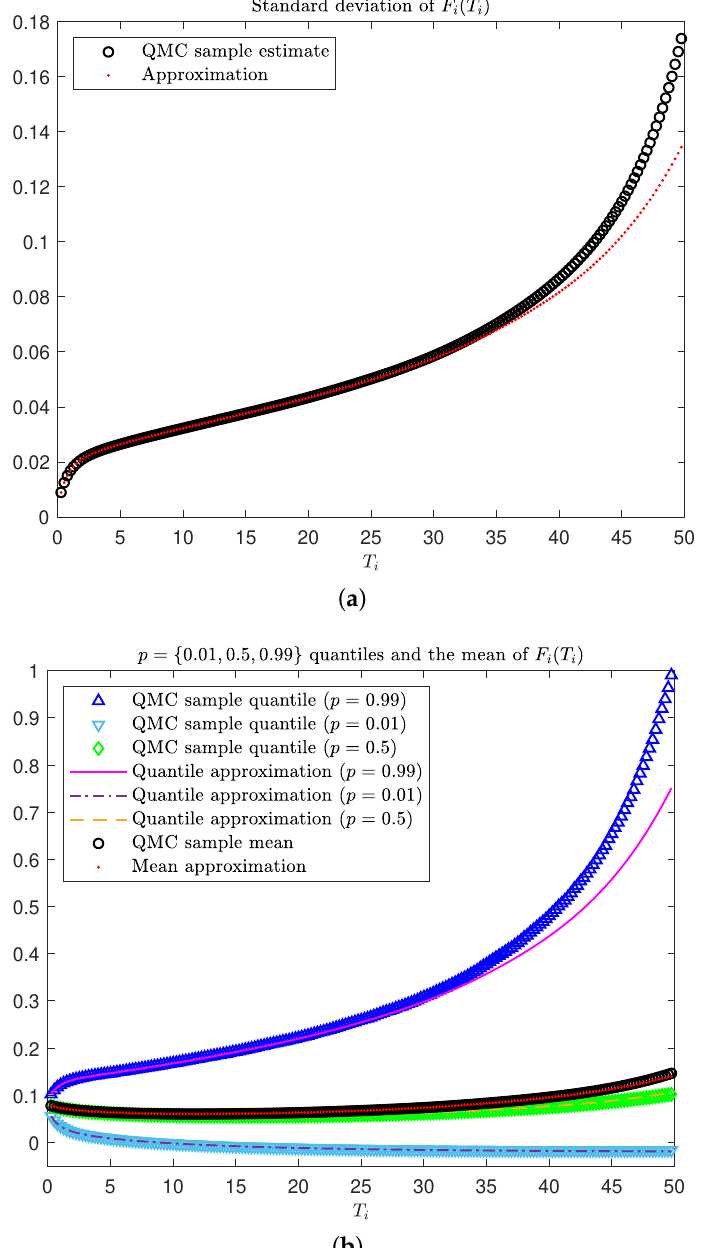
Figure 3. Diagnostic tool for analysing the distribution of long-dated forward LIBORs in the five-factor DLFM scenario. ( a ) Comparing the realised forward LIBOR standard deviation ap- proximation to a benchmark QMC sample estimate. ( b ) Comparing the realised forward LIBOR p = { 0.01,0.5,0.99 } quantiles and mean approximations to their benchmark QMC sample